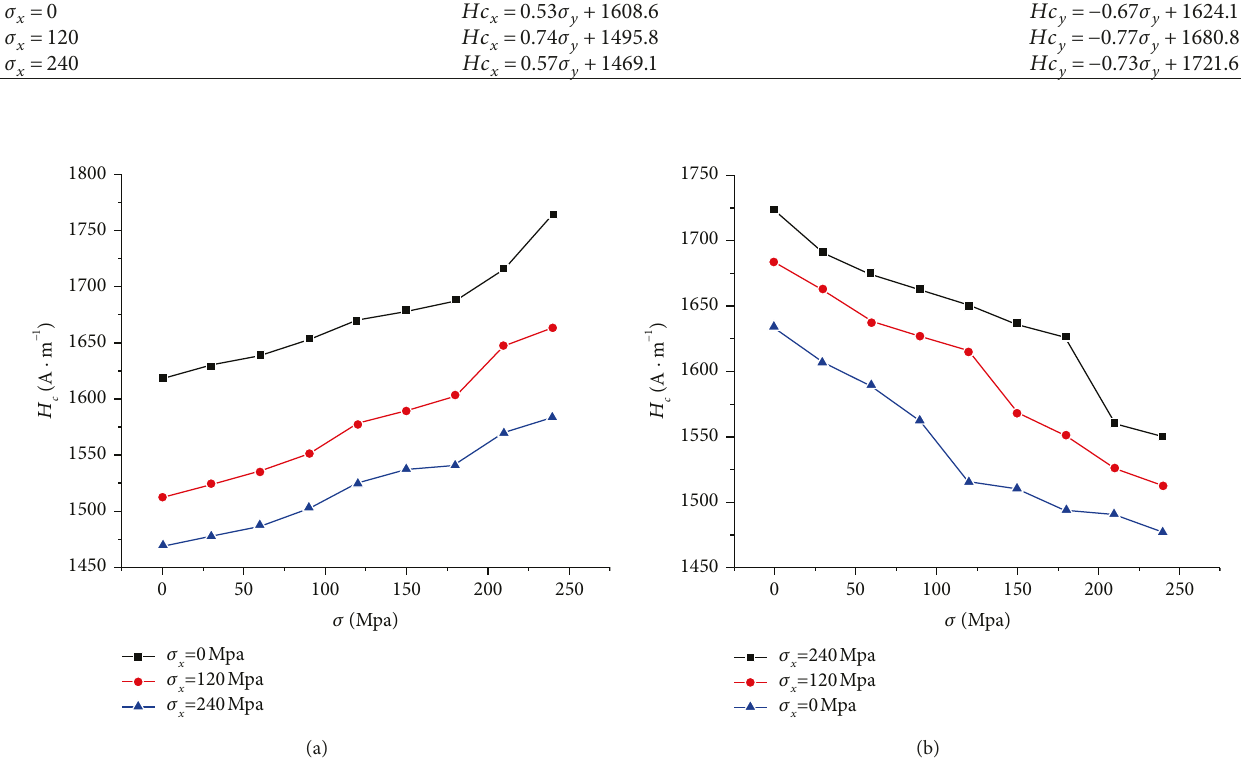
Figure 15: Stress-coercivity relationship of specimen 1 under three σ diagram of test piece 1 under different σ x .